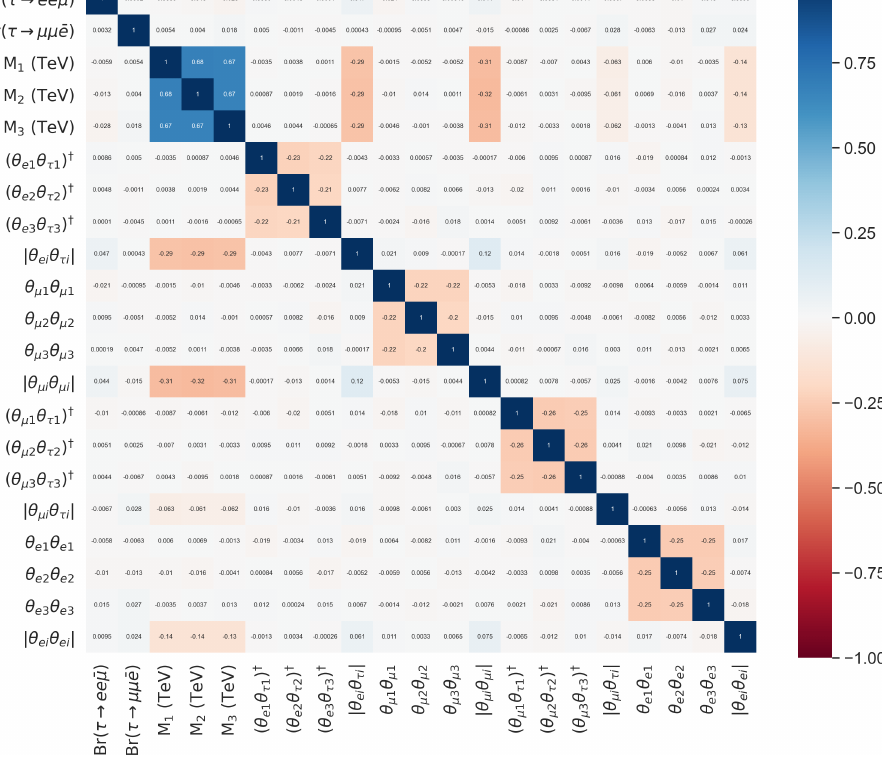
Figure 19 . Heat map that stands for a correlation matrix among wrong sign branching ratios and free